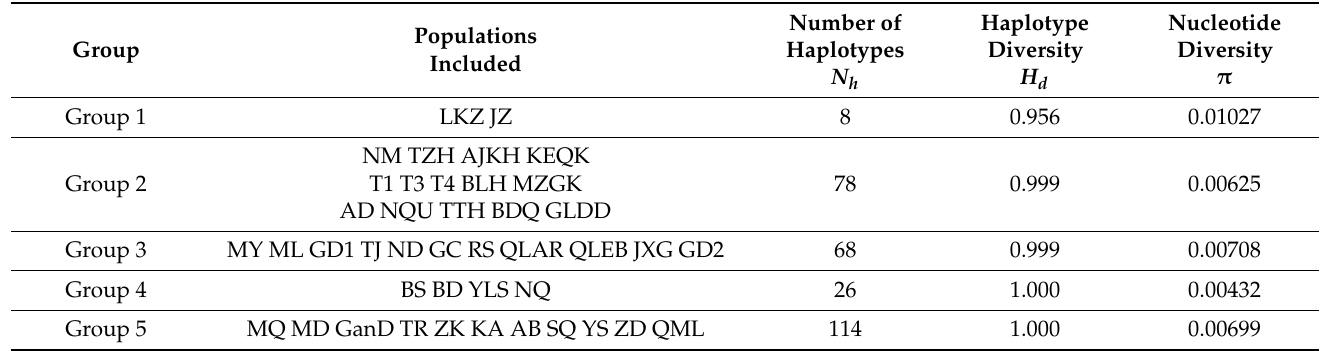
Table 4. Genetic diversity of each group of plateau pika populations based on the combined